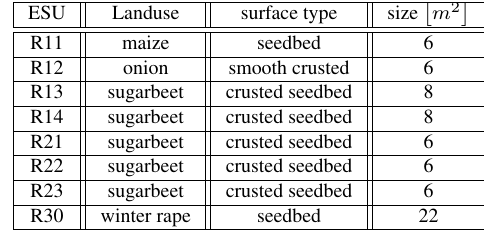
Table 1: Characteristics of sample points acquired within this study al. (2012a). As LPS needs for establishing the exterior orientation Ground Control Points (GCPs), a reference frame in the size